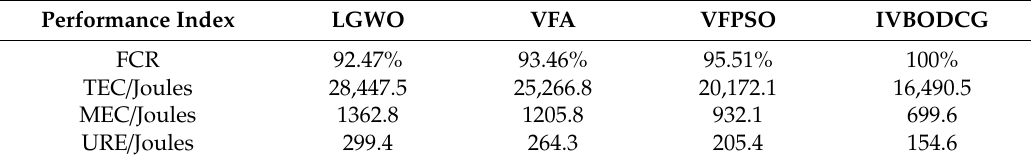
Table 2. Performance comparison of 200 simulation experiments with the average